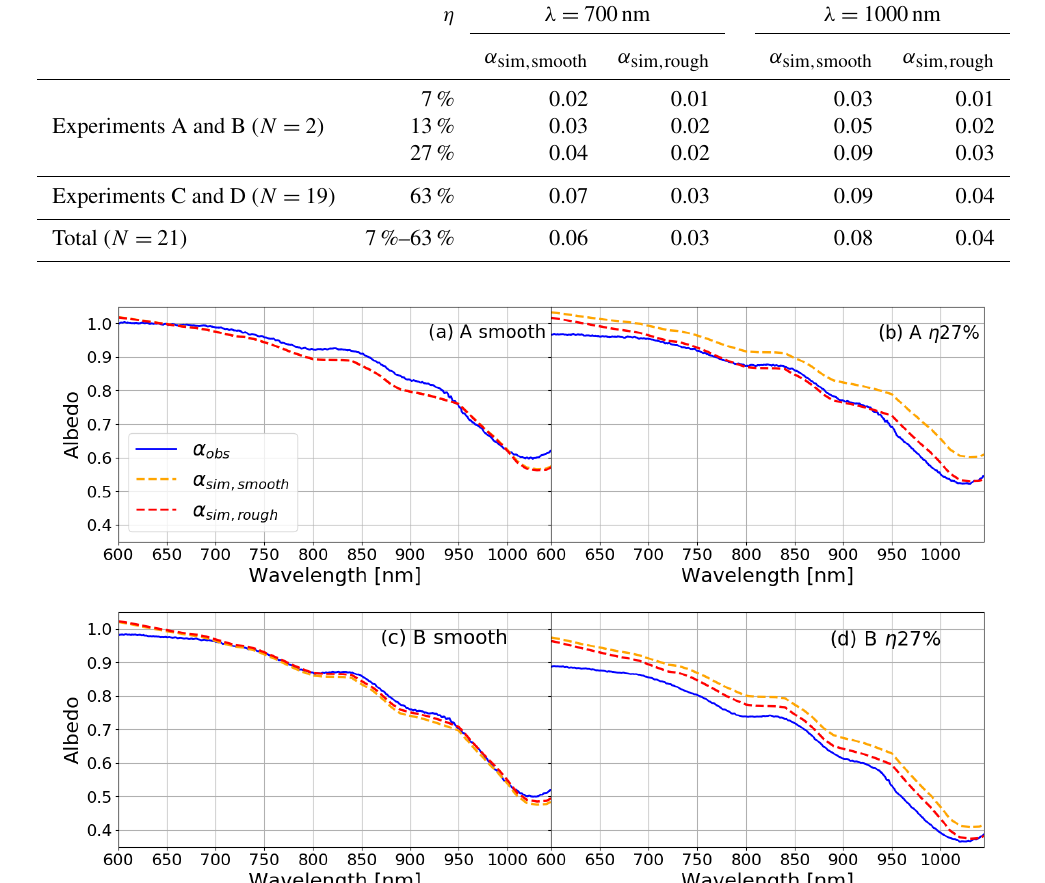
Figure 5. Measured spectral albedo α obs (blue solid lines), and spectral albedo simulated with RSRT by considering the surface as smooth ( α sim , smooth ; orange dashed lines) and by considering surface roughness ( α sim , rough ; red dashed lines) for (a) A smooth, (b) A η 27%, (c) B smooth and (d) B η